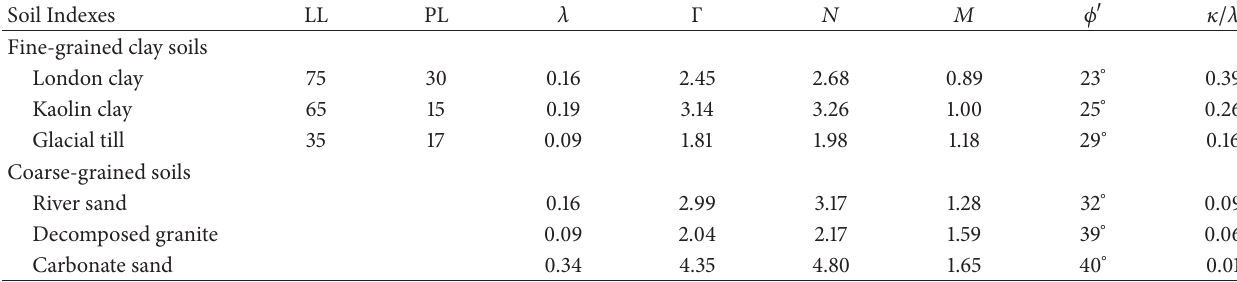
Table 2: Critical state parameters of some soil types [20].